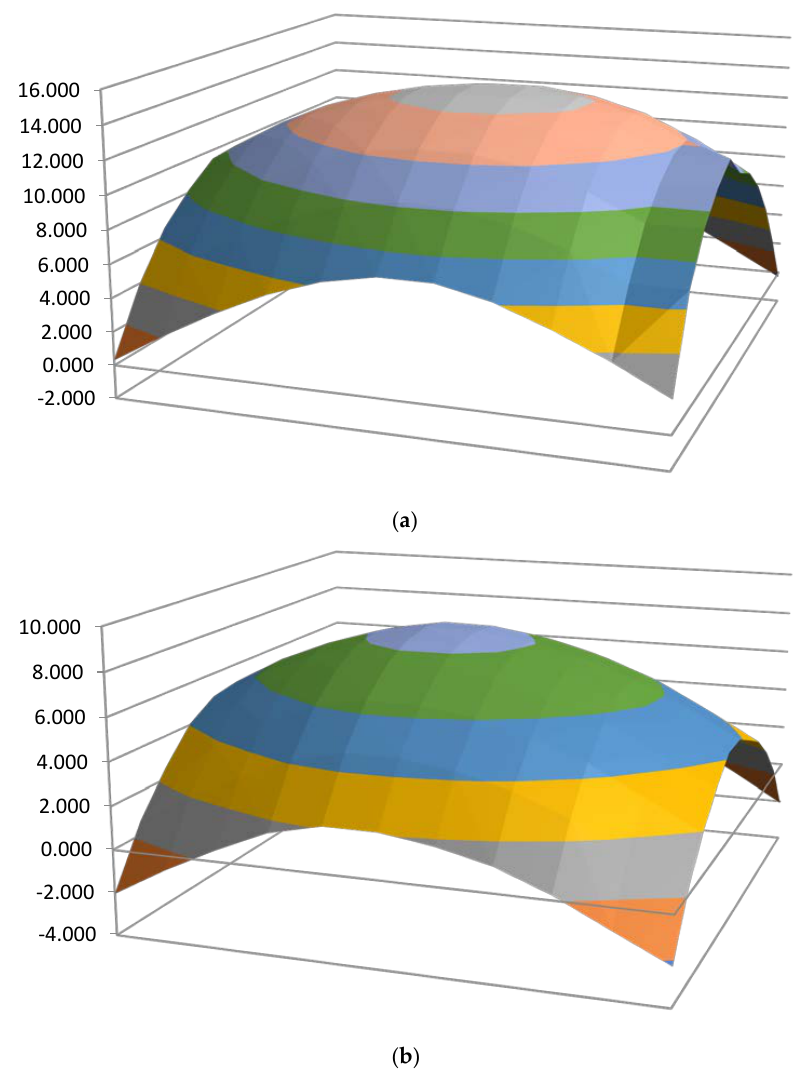
Figure 2. ( a ) Three dimensional surface chart of Part 1 morphology, in mm; ( b ) Three dimensional surface chart of Part 2 morphology, in mm.